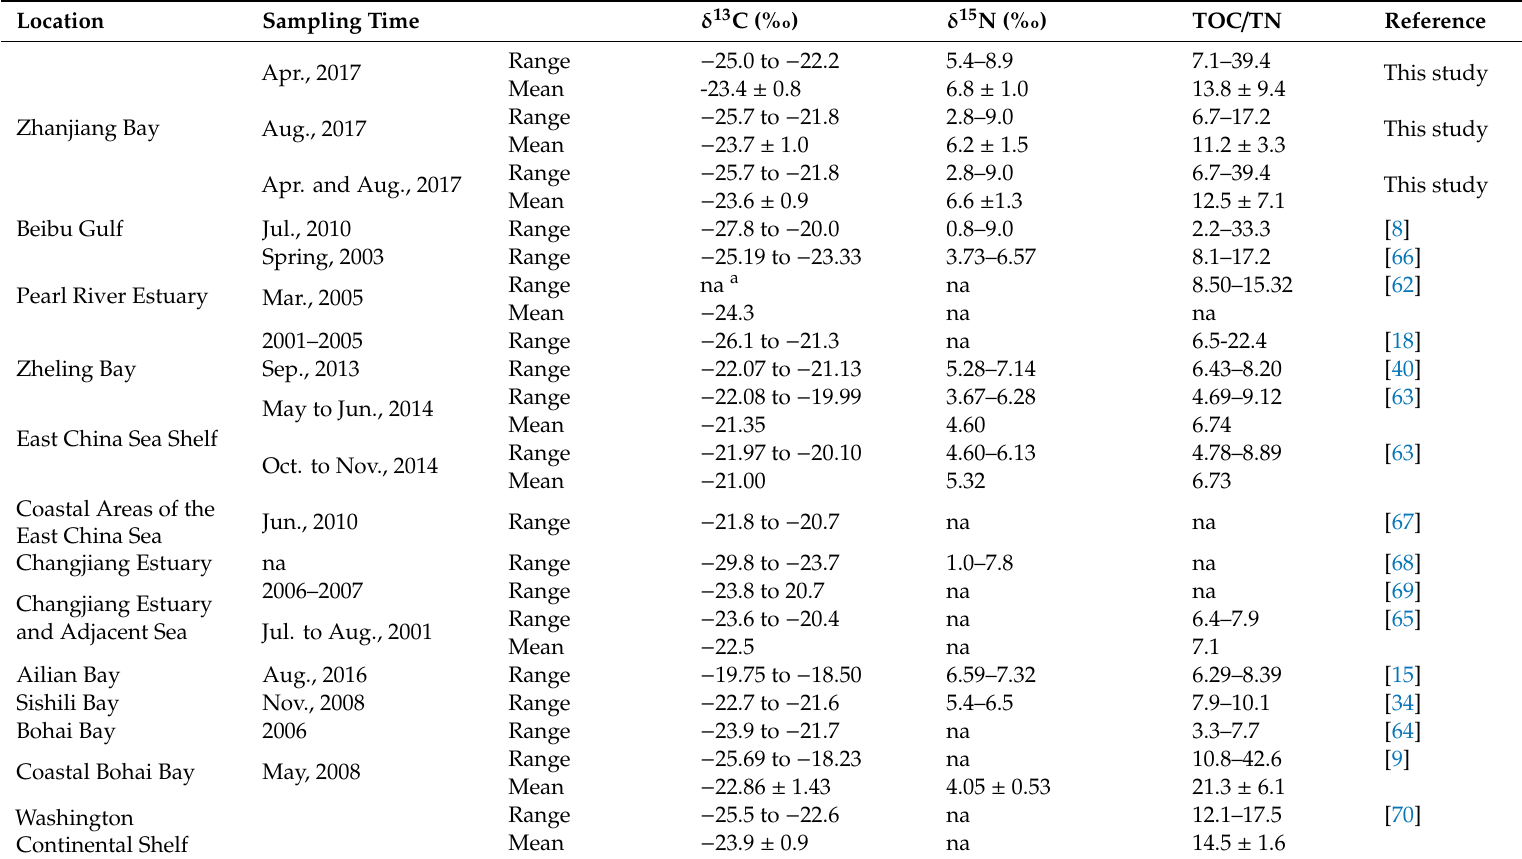
Table 4. Comparison of δ 13 C, δ 15 N, and TOC / TN ratios in the sediments of Zhanjiang Bay with related data.